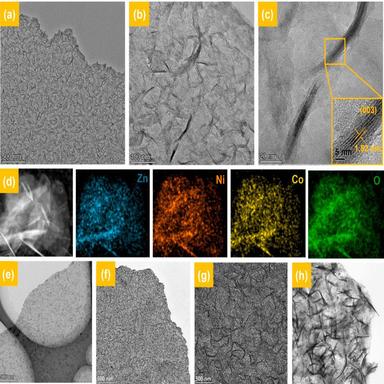
TEM and EDS mapping images of (a-d) Zn0.25Ni0.75Co-LDH-BA– , (e) Zn0.25Ni0.75Co-LDH-AA– , (f) Zn0.25Ni0.75Co-LDH-NO3 – , (g) Zn0.5Ni0.5Co-LDH-NO3 – , and (h) Zn0.75Ni0.25Co-LDH-NO3 – .